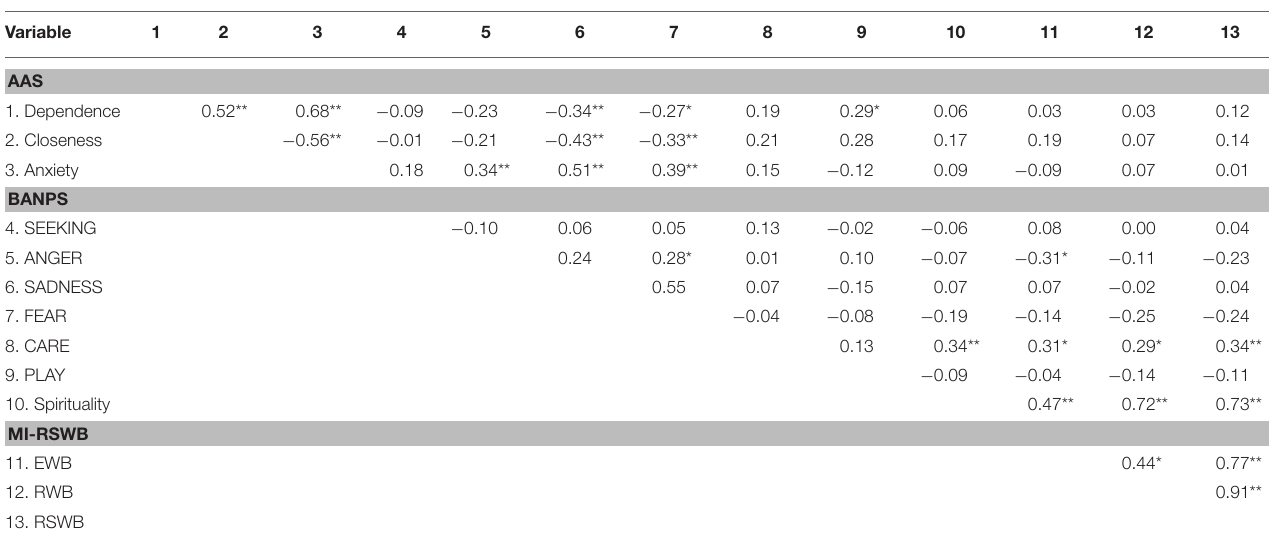
TABLE 3 | Intercorrelations for behavioral measures.